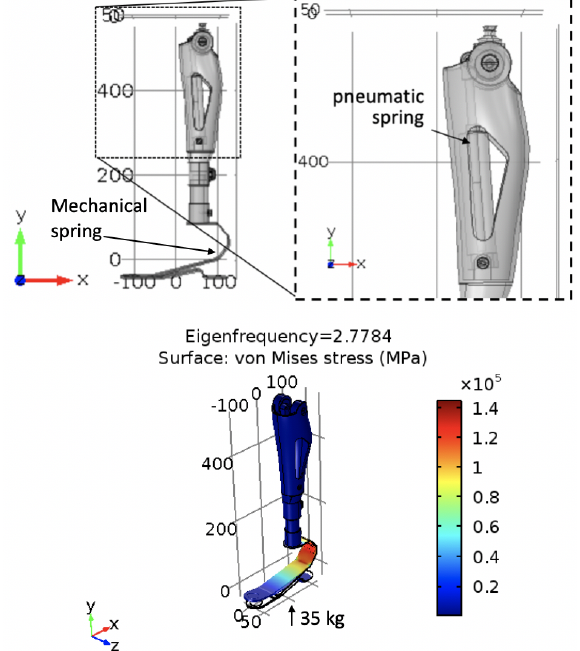
Figure 3. CAD model ( top ) and FEA simulation of the first eigenfrequency ( bottom ) for a carbon fibre prosthetic limb. Thirty-five kilograms of added mass was assumed on the prosthetics to simulate a human above lower limb body mass of 70 kg. The CAD model is adapted from GRABCAD